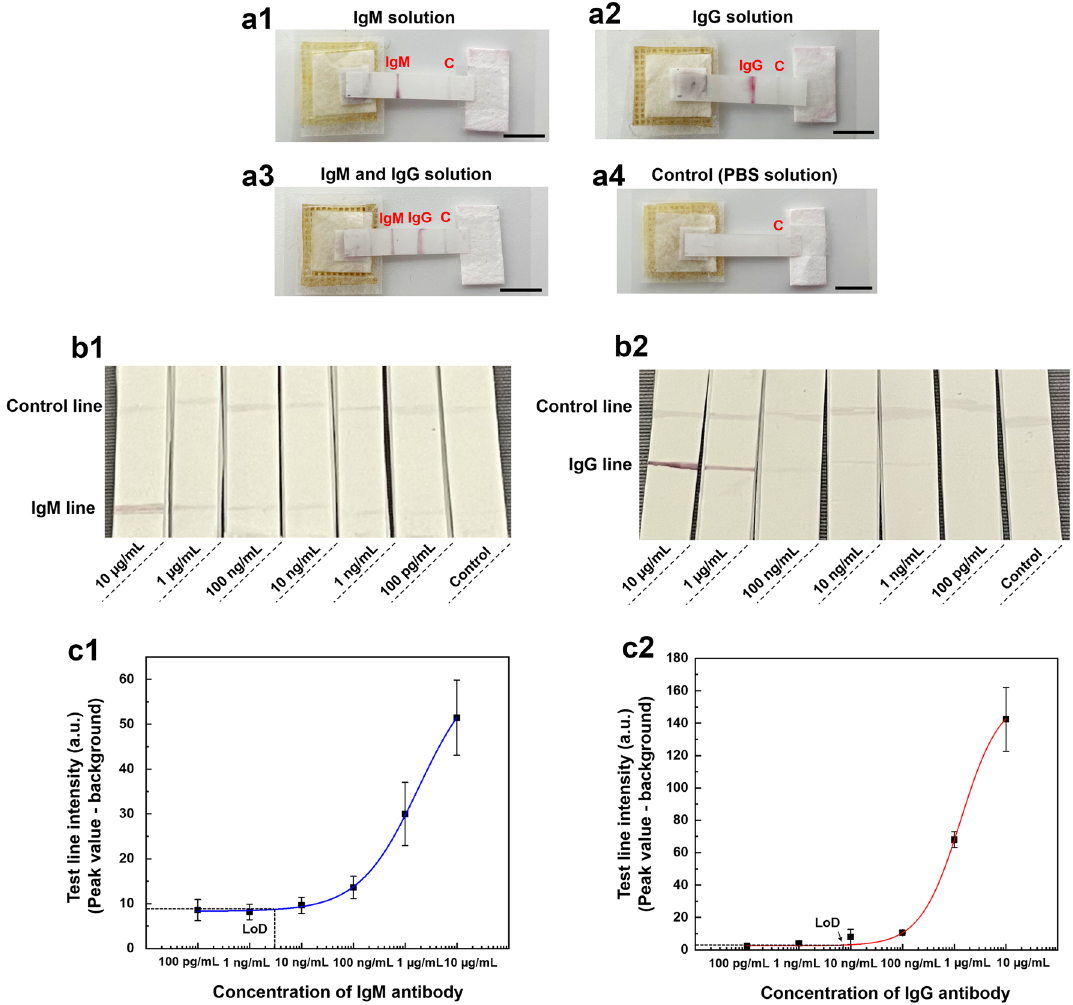
Figure 6. Detection of SARS-CoV-2-specific IgM/IgG antibodies using patch integrated porous MNs and paper-based immunoassay and its sensitivity. ( a ) Visual test results of sample ISF containing IgM ( a1 ), IgG ( a2 ), mixture of IgM and IgG ( a3 ), and blank control ( a4 ). Scale bar, 5 mm. ( b ) Detection of anti-SARS-CoV-2 IgM ( b1 ) and IgG ( b2 ) with different concentrations. ( c ) The average color intensity of IgM line ( c1 ) and IgG line ( c2 ), and their fitted curves. The graphs were obtained by analyzing three independent detection patches (n = 3) for each target concentration and the fitted curves correspond to the following equation: y = start + (end – start) × x n /(k n + x n ). For IgM detection ( c1 ): start = 8.29 ± 0.29, end = 63.24 ± 3.12, k = 1801.30 ± 732.86, n = 0.76 ± 0.09 with R 2 = 0.998; For IgG detection ( c2) : start = 2.54 ± 0.43, end = 157.29 ± 33.49, k = 1322.64 ± 534.49, n = 1.12 ± 0.11 with R 2 =